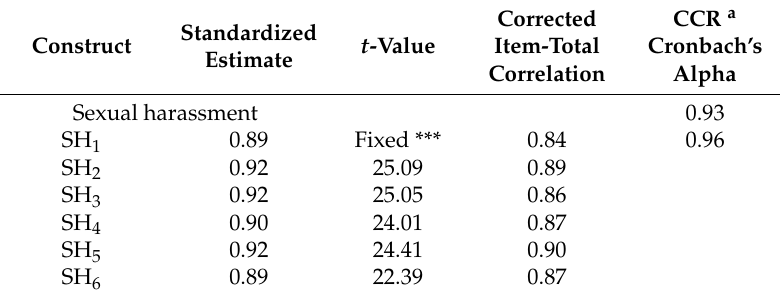
Table 1. Confirmatory factor analysis and reliability